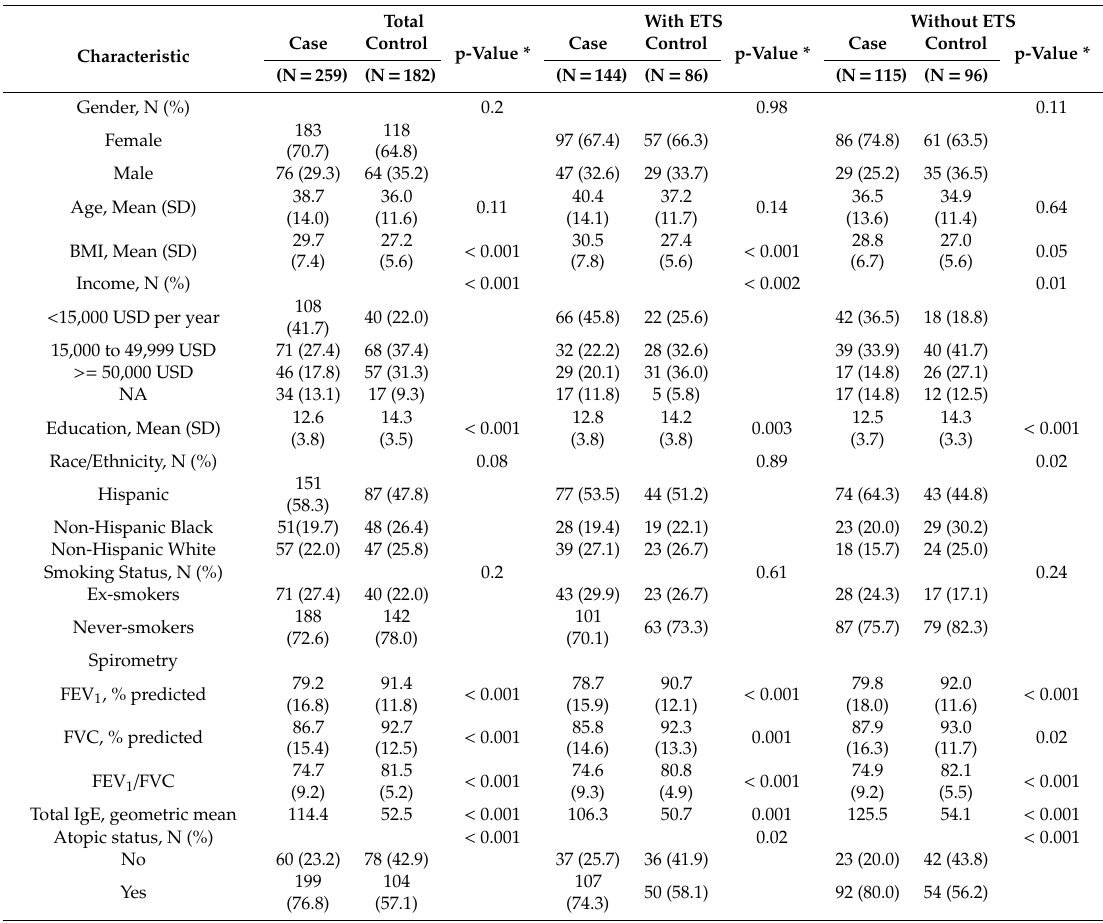
Table 1. Characteristics of study population.